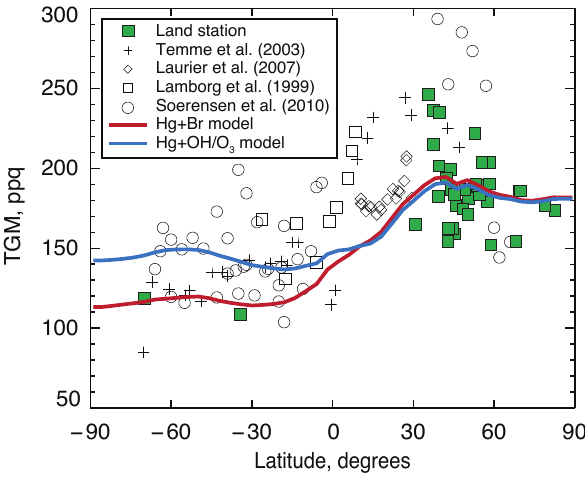
Fig. 6. Meridional gradient of total gaseous mercury (TGM). The model is averaged zonally during 2006–2008. Observations are the same as in Fig.